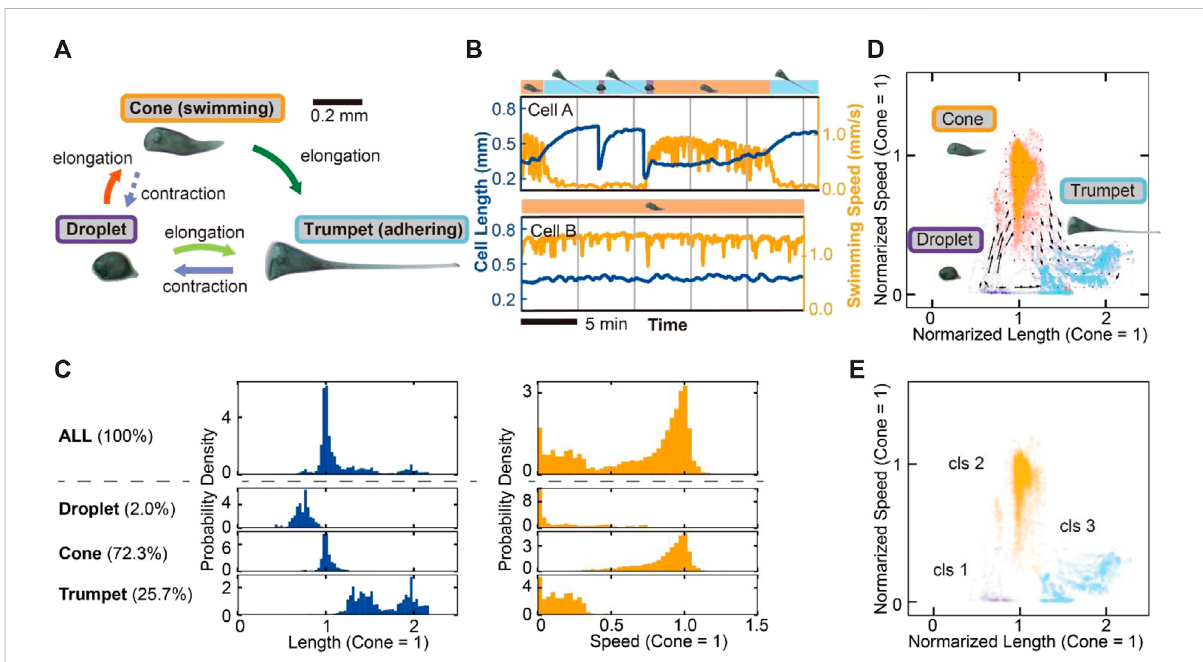
FIGURE 1 Threemodesandtransitionsof S.coeruleus andthevarietyofbehavioralmodesinthequasi-2Ddiskchamber. (A) Schematic imagesofthecell states and the transitions. The cell takes three shapes (droplet, cone and trumpet). The cell elongates or contracts between these states, correspondingtoeacharrow.Intheshapetransitionfromconetotrumpet,theswitchingbehavioroccursfromswimmingtoadheringtoasubstrate. (B) The time series of cell length (blue line) and swimming speed (orange line). The graph displays the behaviors of two cells (Cell A, B). The cell statesareshownonthetopofeachgraph.CellAoftenexperiencesashapetransition;ontheotherhand,CellBremainsinaswimmingconestatefor alonger observationtime. (C) The frequencyofthecell stateand thedistributionsofthecelllengthand speedineachstate.Eachstate wasmanually divided(droplet,2.0%;cone,72.3%;trumpet,25.7%).Thedistributionsofthelengthandthespeedwerenormalizedbycalculatingaveragedvaluesin the cone state. The length in the droplet is shorter than that in the cone. On the other hand, the length in the trumpet shape is higher than that in the cone. Swimming speed is separated into two regions, the swimming state (cone) and the adhering or lower swimming state (droplet and trumpet). (D) The transition vector of the cells. The dots represent the cell states in the 2D fi eld containing the cell length and speed at time points. The speed and length are normalized by cone = 1. The dots were manually classi fi ed into three by cell state Tartar ’ s classi fi cation (droplet, purple; cone,orange;trumpet,lightblue). (E) Hierarchicalclusteringofthesteadycellstates.Thedotsinthe2Dstate fi eldaredividedintothreeclusters.The computational clustering is similar to manual classi fi cation (D)